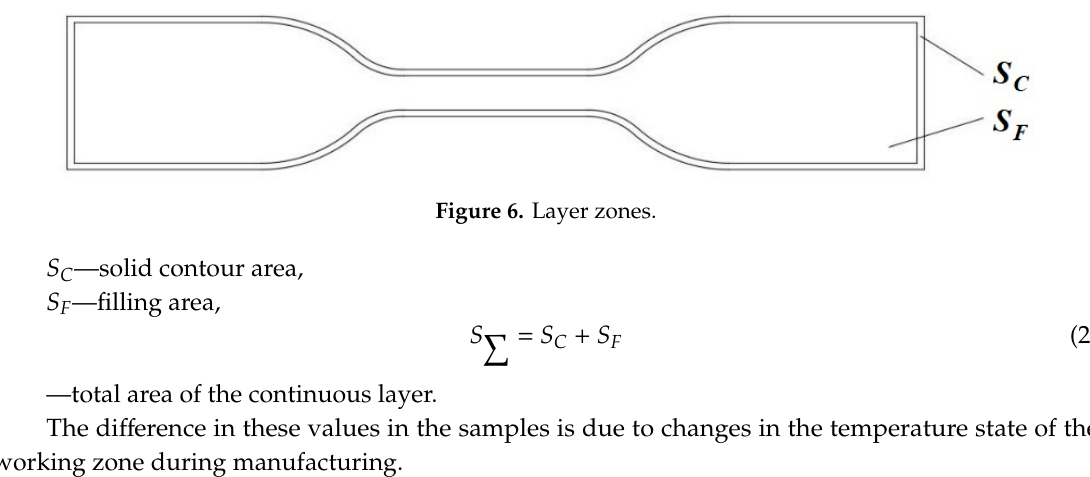
Figure 6. Layer zones.